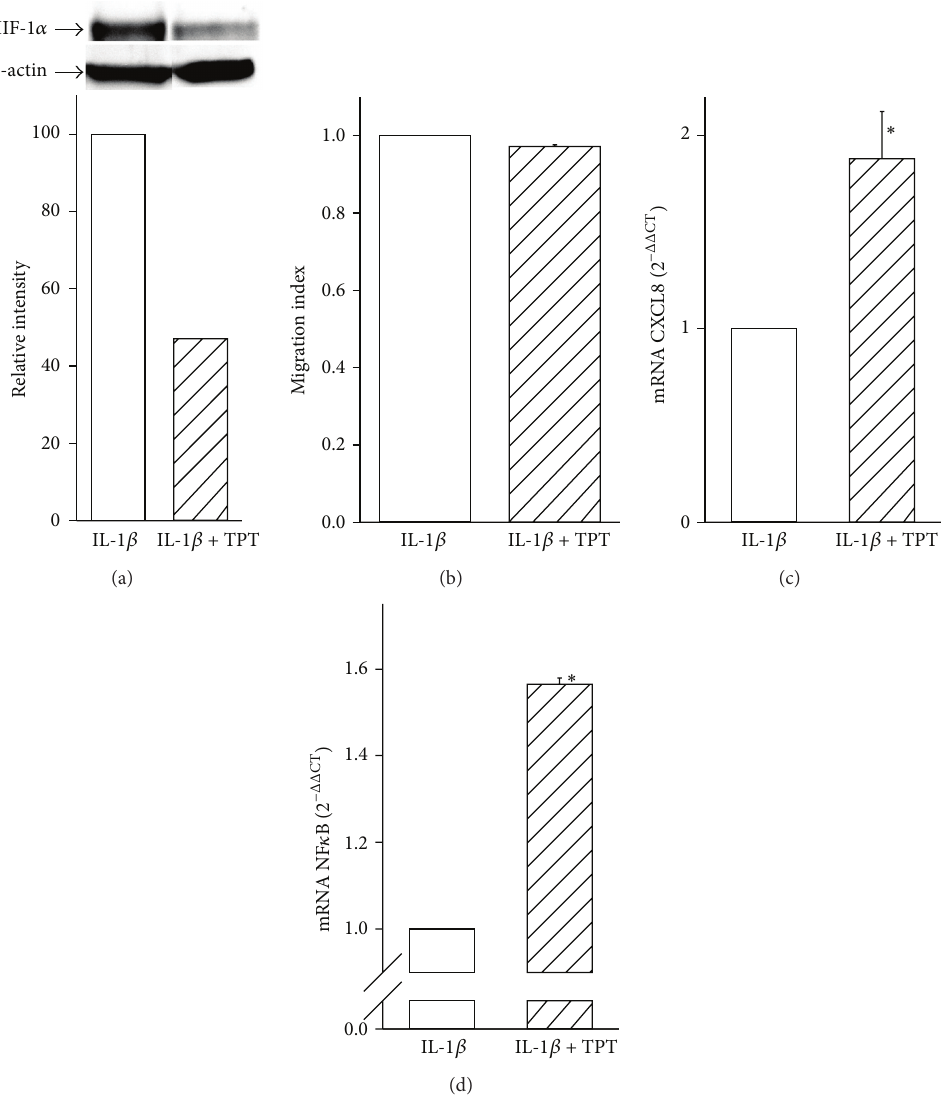
Figure 3: Topotecan does not reduce the induction of hypoxic breast cancer cell migration by IL-1 𝛽 . Data are shown as means ± SEM. ∗ 𝑃 < 0.05 , statistically significant difference between IL-1 𝛽 -treated hypoxic cells in the presence of Topotecan (IL-1 𝛽 + TPT) versus IL- 1 𝛽 -treated hypoxic cells in the absence of Topotecan (IL-1 𝛽 ). (a) Protein expression of HIF-1 𝛼 was determined by Western blot analysis. A representative blot from three independent experiments is shown. HIF-1 𝛼 protein quantification was achieved by chemiluminescence. (b) Cell migration index was calculated as a fold change of relative fluorescence of cells migrating into the lower chamber normalized to that of the untreated samples (IL-1 𝛽 ) ( 𝑛 = 5 ). (c and d) CXCL8 and NF 𝜅 B mRNA expression was analyzed by qRT-PCR ( 𝑛 = 3 ). enhances HIF-1 𝛼 accumulation in hypoxic MDAMB231